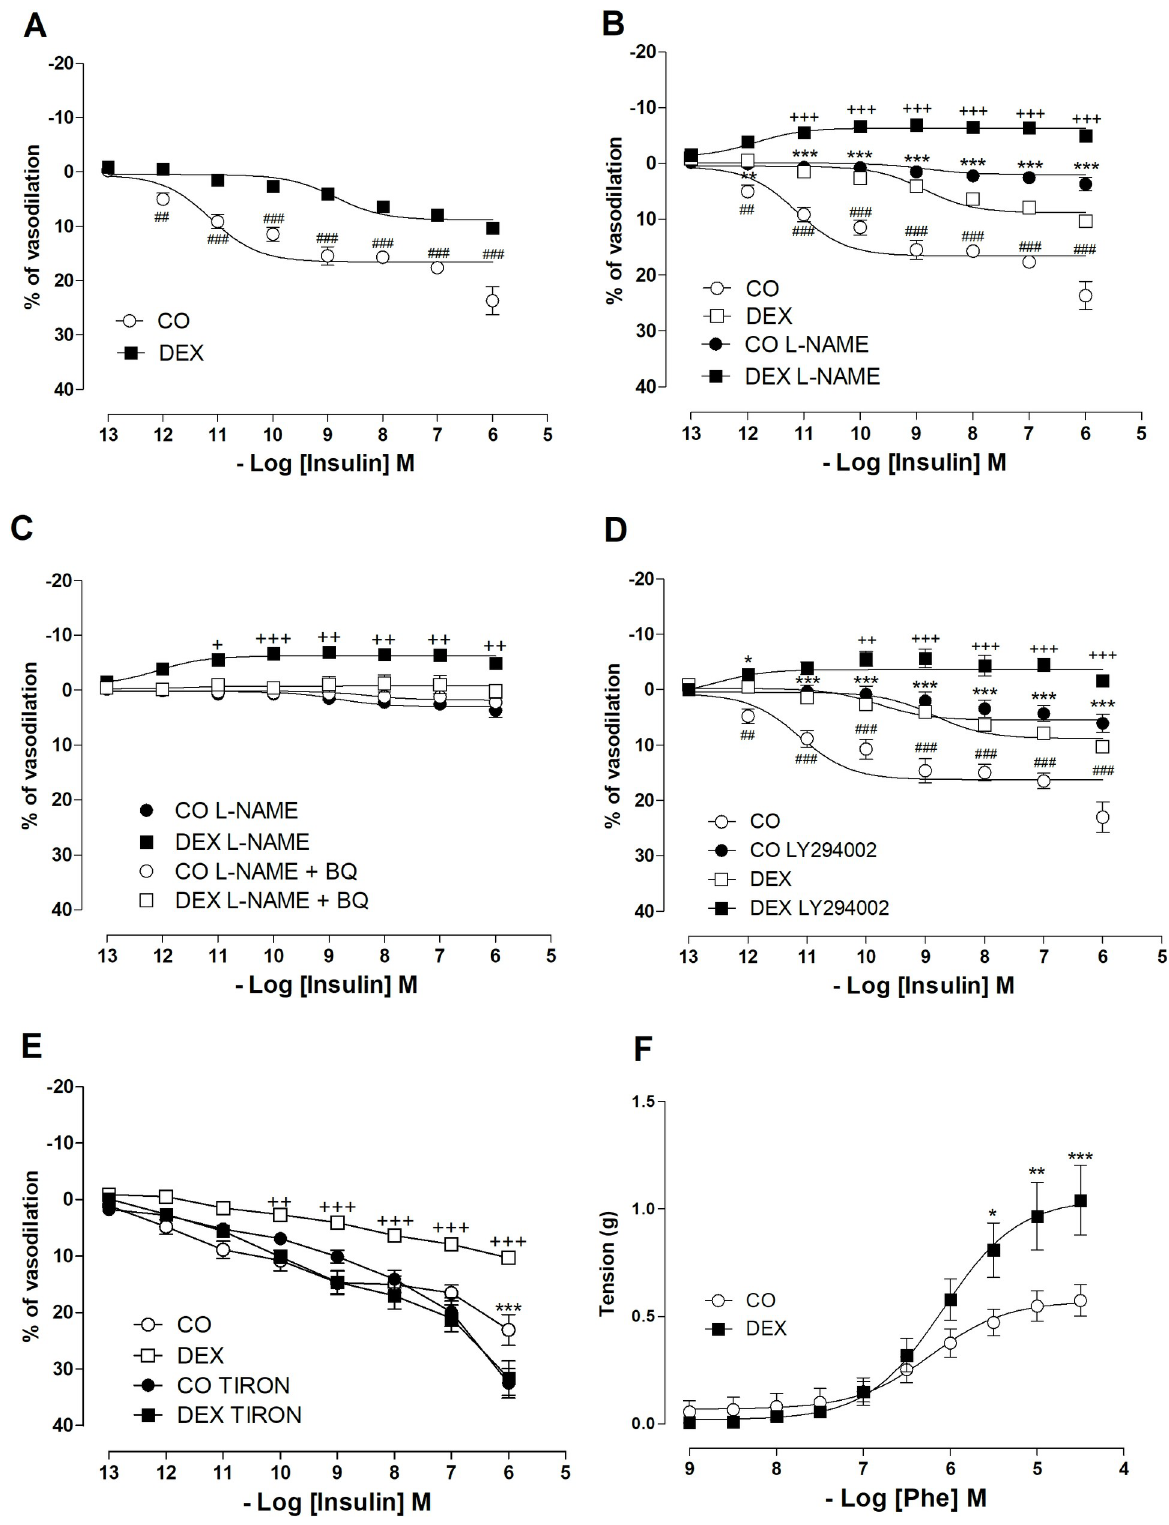
Fig 2. Endothelium-dependent relaxation in response to insulin (INS) in control and insulin-resistant rats. Cumulative concentration- response curves to insulin in intact segments obtained from the superior mesenteric artery of Wistar rats and pre-contracted with